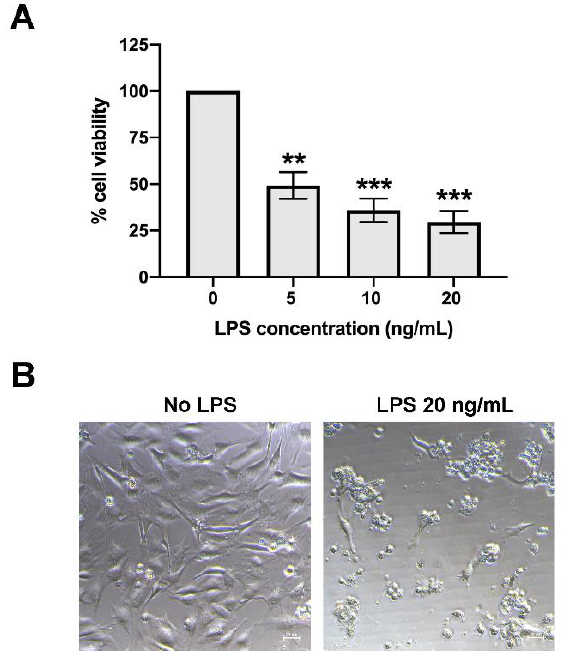
Figure 1. The effect of lipopolysaccharide (LPS) on bovine endothelial cell (EC) death. Bovine ECs were treated with LPS at the concentration of 5–20 ng/mL for 24 h. ( A ) The cell viability was measured using Prestoblue™ reagent, where non-treatment control was set as 100% cell viability (* indicates p < 0.05, ** indicates p < 0.01, and *** indicates p < 0.001). ( B ) The changes in cell morphology upon LPS treatment were observed under the microscope.